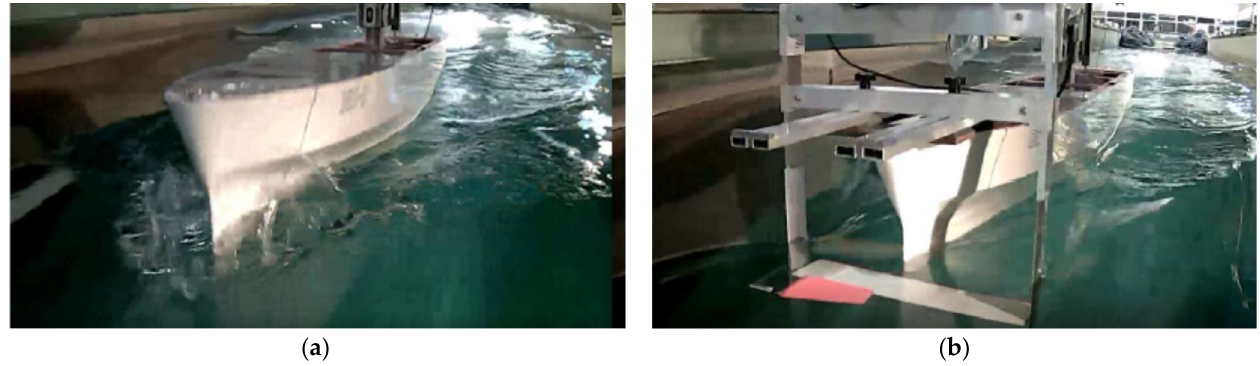
Figure 7. Basic workflow of the control system for the NTUA tank-scale model.